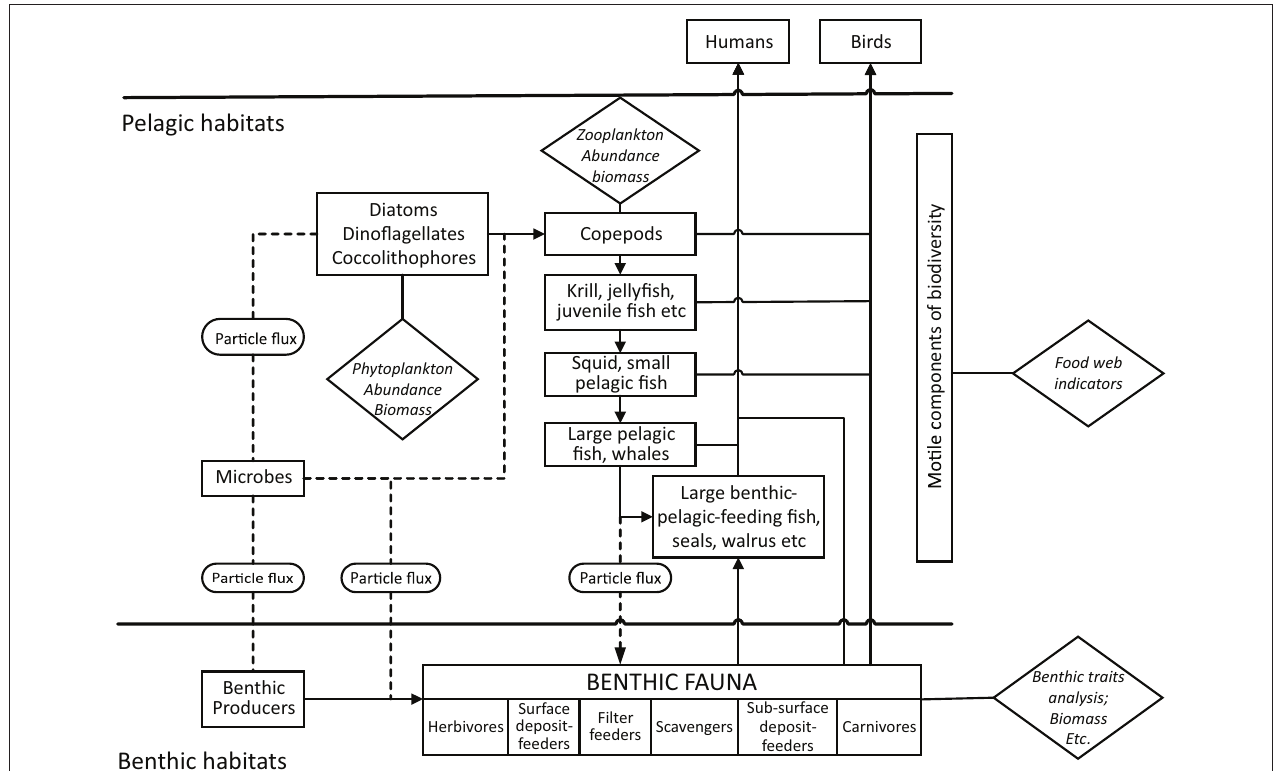
FIGURE 4 | Conceptual illustration of a generic marine